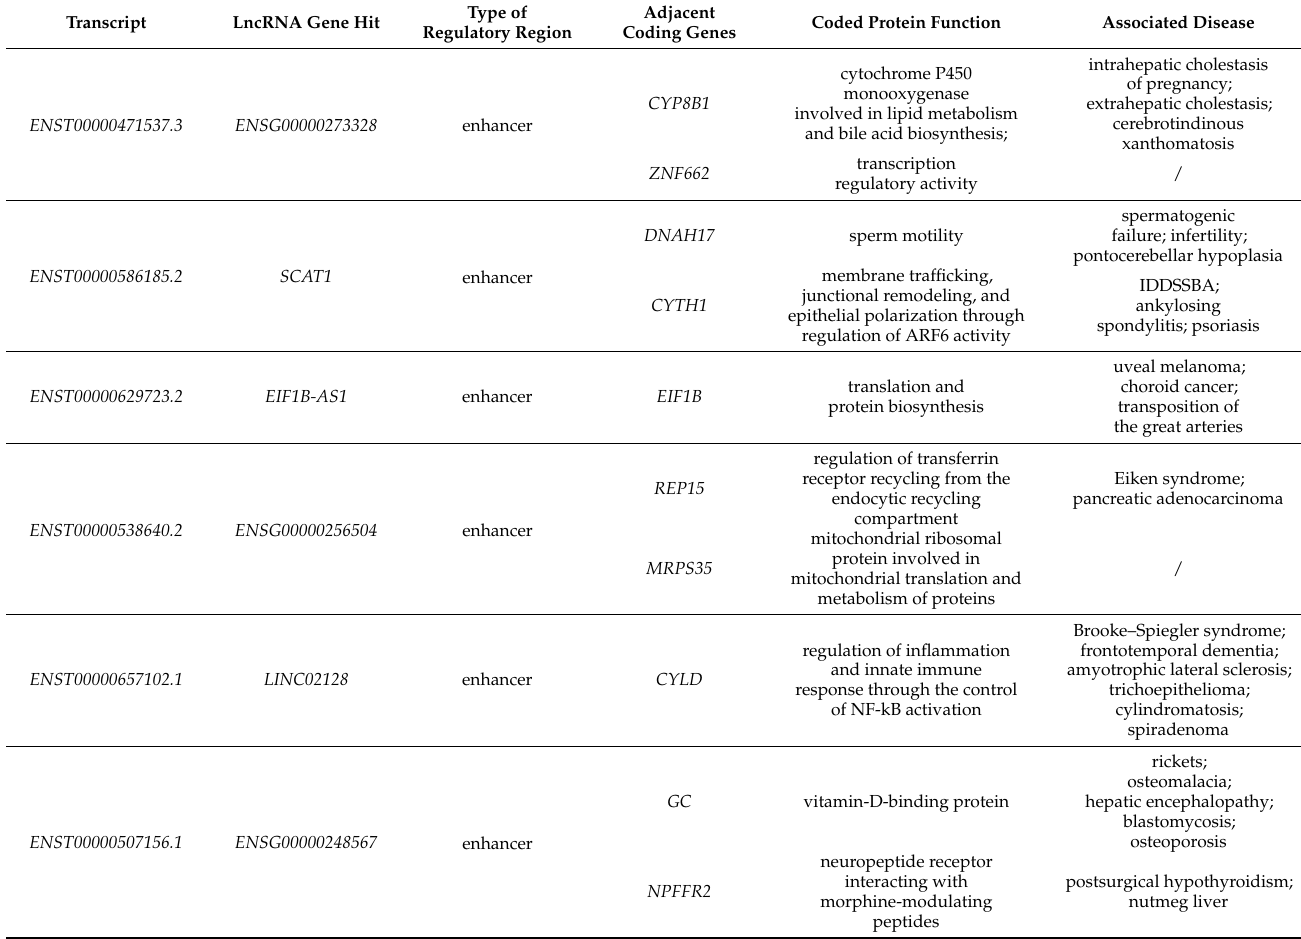
Table 3. LncRNAs having a complementary sequence to the syncytin-2 gene in a regulatory region, and features of adjacent protein-coding genes (ARF6: ADP-ribosylation factor 6; BPNT2: 3’(2’), 5’-bisphosphate nucleotidase 2; CTCF: CCCTC-binding factor; CYP8B1: cytochrome P450 family